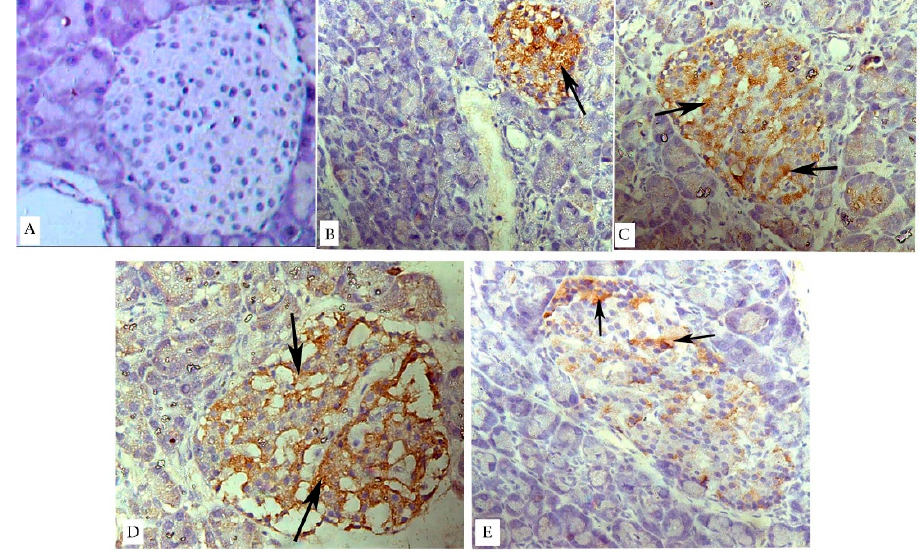
Figure 6. Caspase-3 immunostained photomicrographs of pancreatic islets of the different groups. Arrows mark the brown coloration that is indicative of the positive cytoplasmic reaction. Caspase-3 is not detected in the islet cells of the control rats ( A ). Markedly positive cytoplasmic immunoreaction is noted in the islet cells of the untreated diabetic group ( B ). Treated groups ( C – E ) show a decrease in the caspase-3 immunoreaction, with the least reaction in the combined therapy group ( E ). Magnification: ( A – E ) ×400.